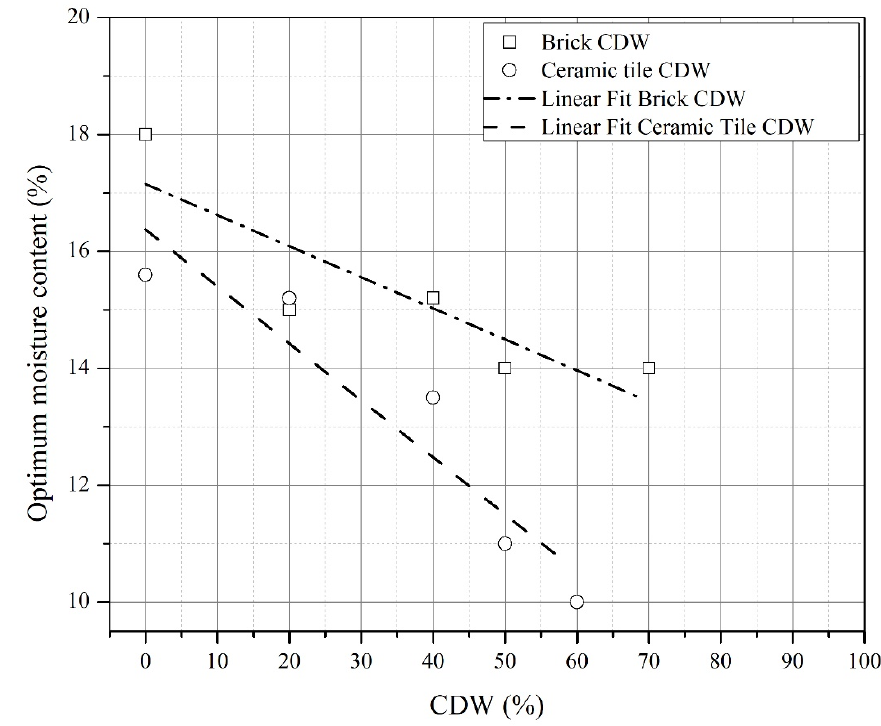
Figure 8. % Moisture ratio and CDW content in the mix.